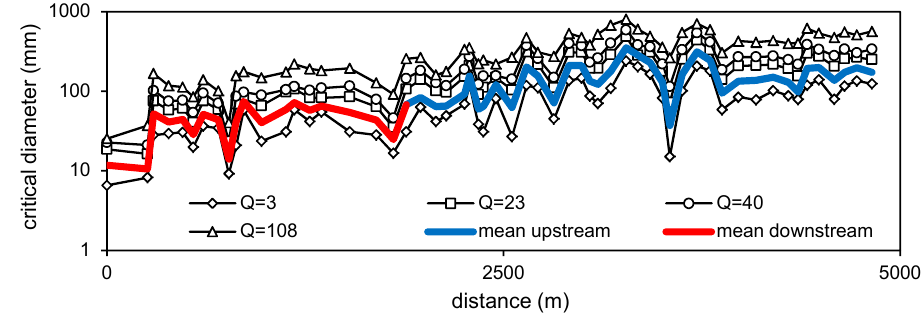
Figure 6. Stream ‐ wise variability of the critical sediment size for a range of flow discharges within the yearly duration curve. Flow rates in the legend are expressed in m 3 /s.